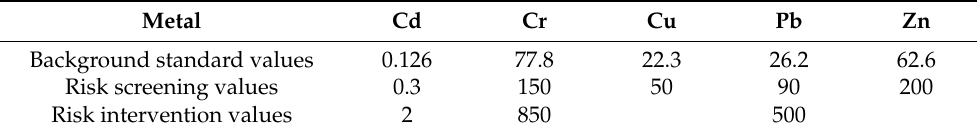
Table 1. Risk control standard for soil contamination of agricultural land and background values for soil in Jiangsu Province /mg · kg − 1 .